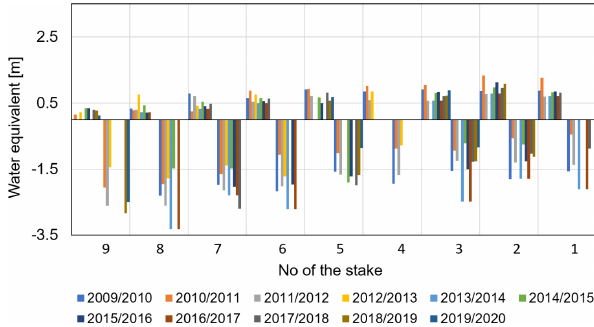
Figure 3. Winter and summer balance at the point on 1–9 mass- balance stakes for the years 2009–2020 For the location and eleva- tion of the stake see Fig. 1 and Table 2. Stakes have been lined up according to a height above sea level.